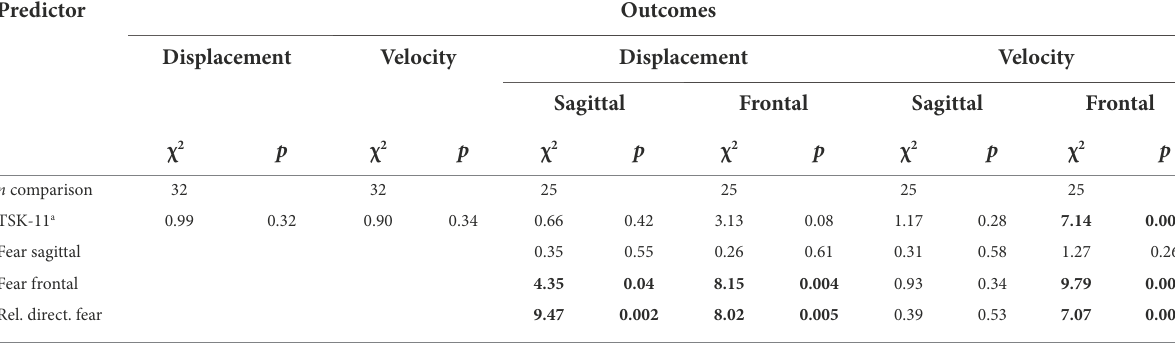
TABLE 4 Comparisons between the baseline model and the baseline model including an additional fear predictor